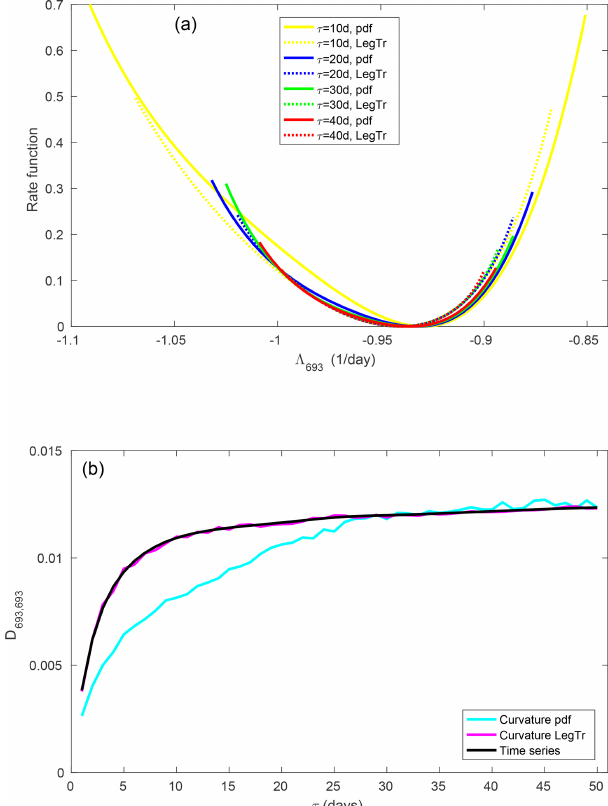
Figure 11. (a) Large-deviation rate function of the 693th FTLE. (b) Element D 693 , 693 of the diffusion